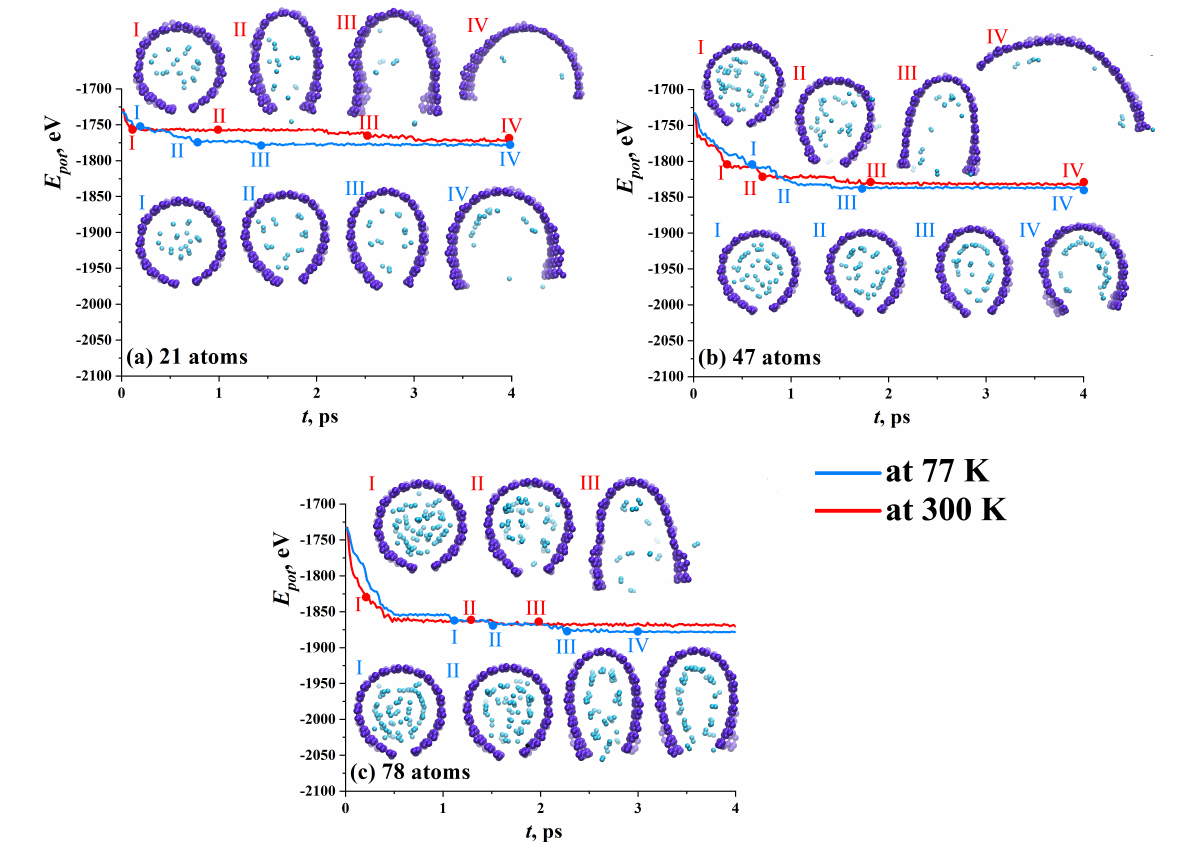
Figure 6. Potential energy as the function of exposure time for three types of hydrogen nanoclusters: ( a ) 21 atoms; ( b ) 47 atoms; and ( c ) 78 atoms. Corresponding snapshots of graphene flake filled with nanocluster during exposure at 77 K (bottom line of snapshots) and 300 K (upper line of snapshots). Carbon atoms are shown by violet and hydrogen atoms are shown by